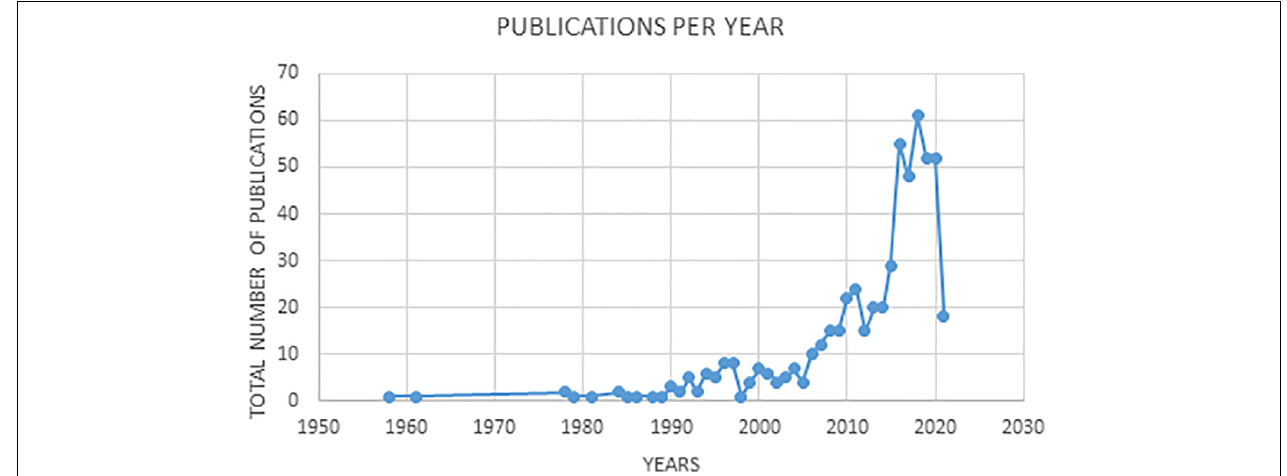
FIGURE 1 | Evolution of the frequency of publications in art therapy over time.